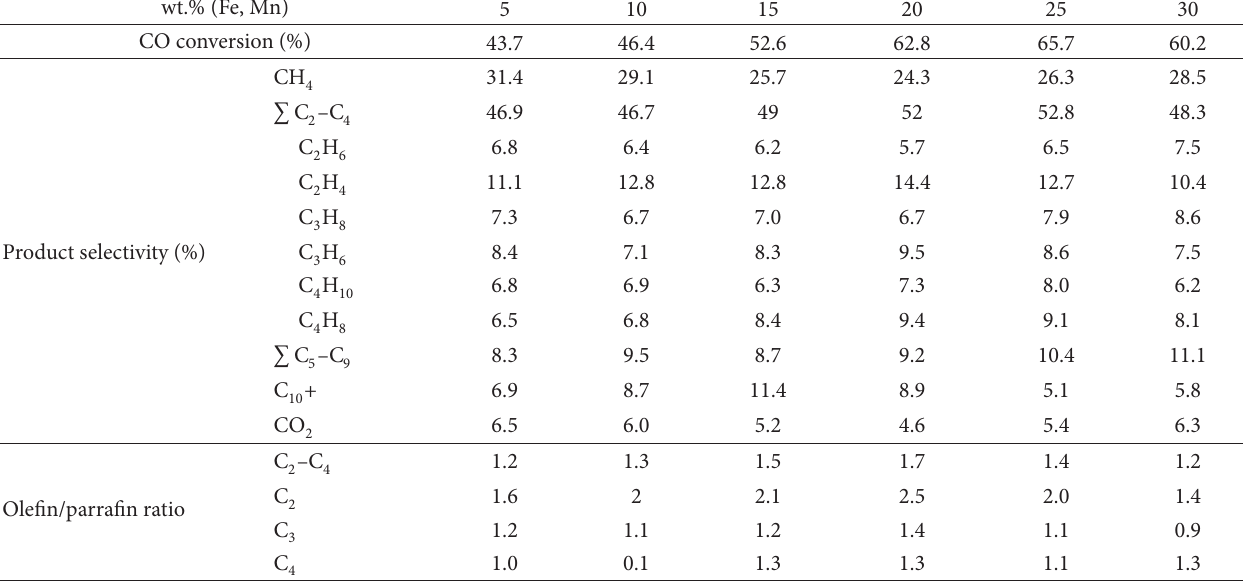
T 1: Effect of loading of (Fe-Mn) on the catalytic performance of catalysts.